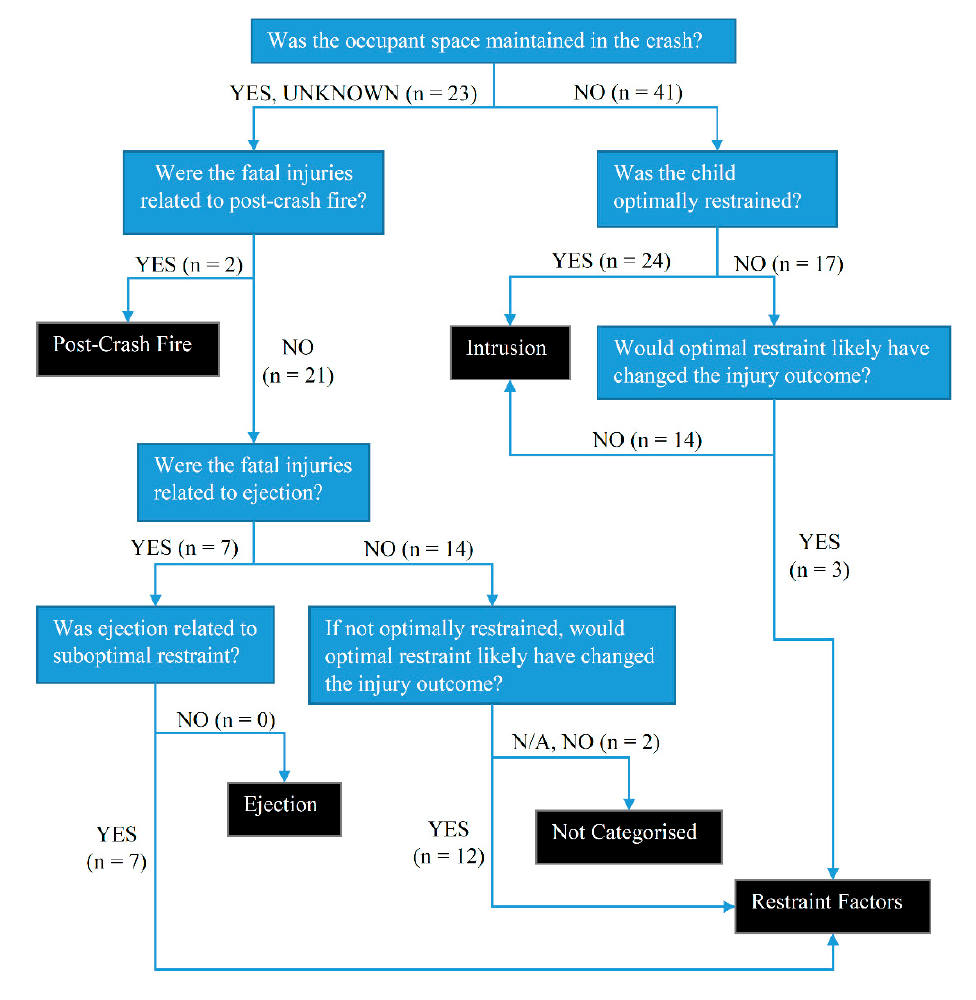
Figure 1. Flow chart for determining the primary contributor to death (black boxes) and the distribution of cases (in brackets).